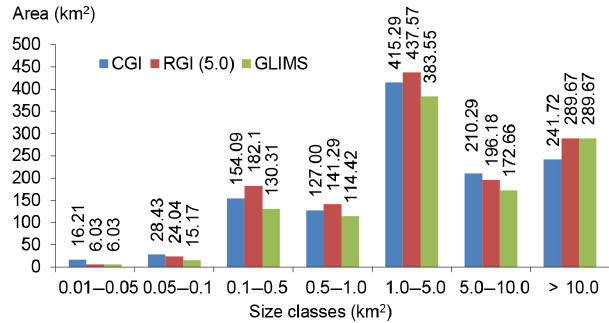
Figure 11. Glacier area comparison for seven glacier classes in the Greater Caucasus according to the RGI (5), GLIMS and new Cau- casus Glacier Inventory